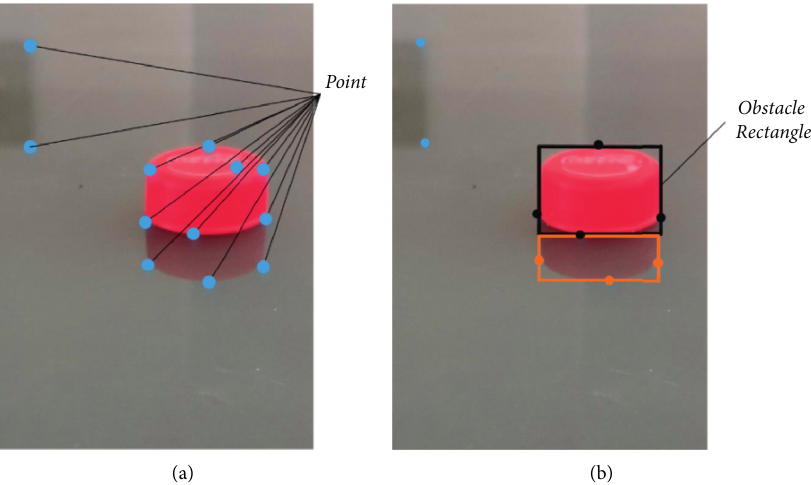
Figure 14: The second image. (a) The feature points. (b) Construction of the obstacle rectangle by the feature